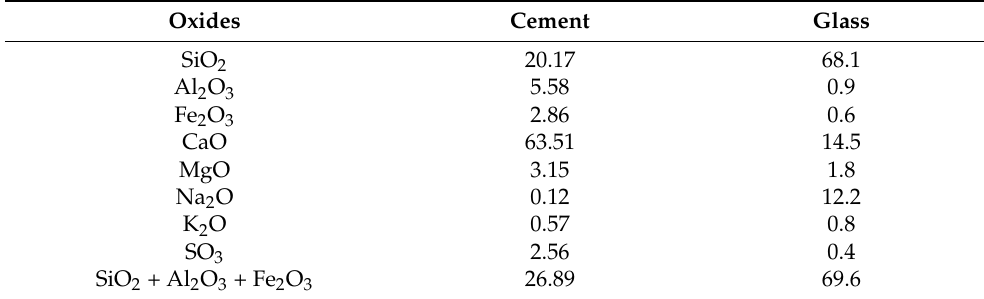
Table 1. Oxide composition of raw